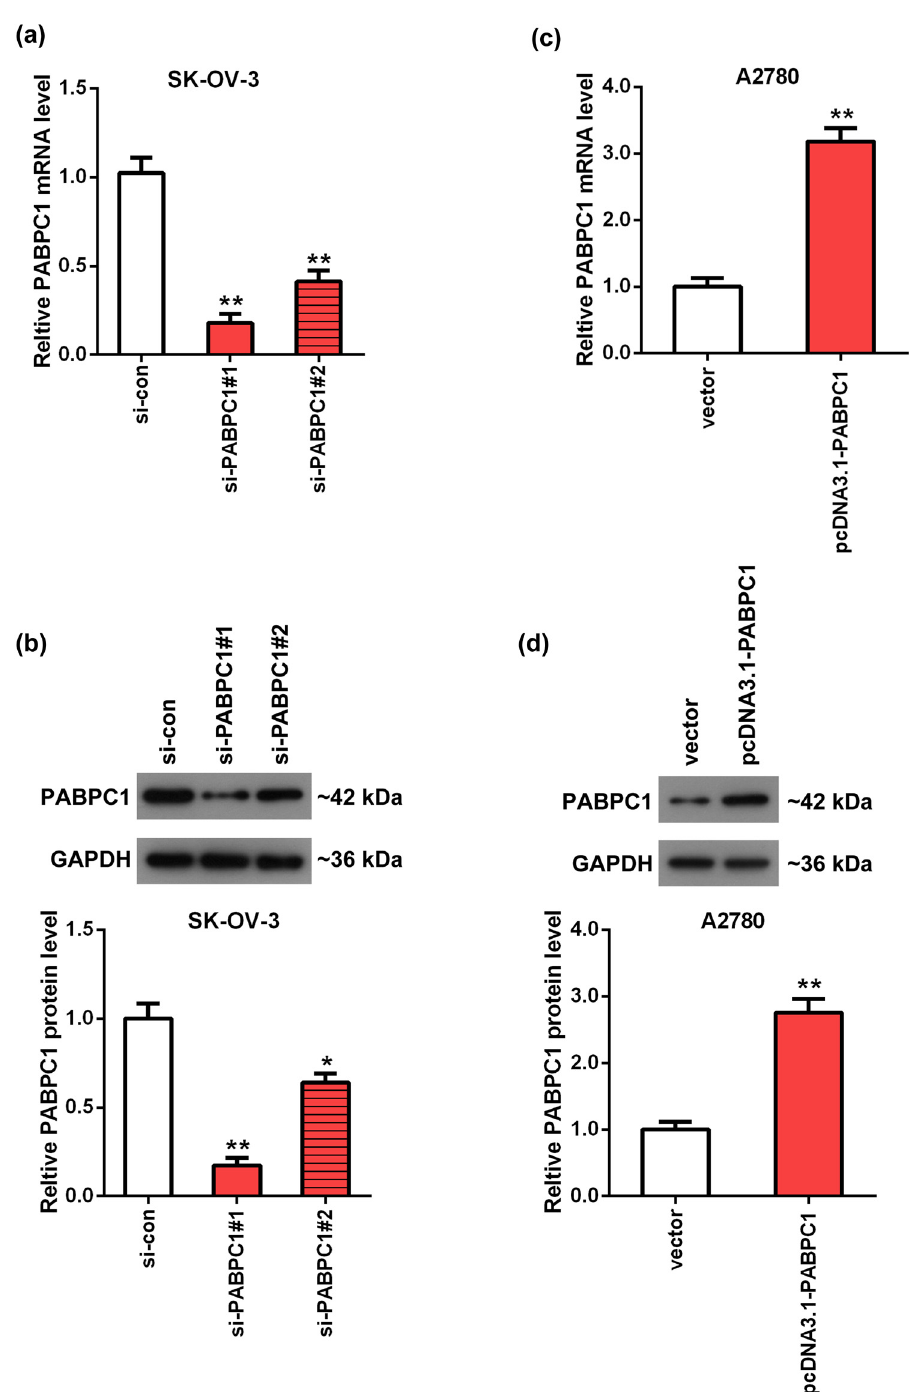
Figure 2: Detection of knockdown and overexpression of PABPC1 e ffi cacy. The mRNA ( a and c ) and protein ( b and d ) levels of PABPC1 in SK - OV - 3 ( a and b ) and A2780 ( c and d ) cells were tested using RT - qPCR ( a and c ) and Western blot ( b and d ) analyses. SK - OV - 3 cells were transfected with si - PABPC1#1, si - PABPC1#2 and si - con. A2780 cells were transfected with pcDNA3.1 - PABPC1 and pcDNA3.1 empty vector. ** P < 0.01 vs si - con or vector